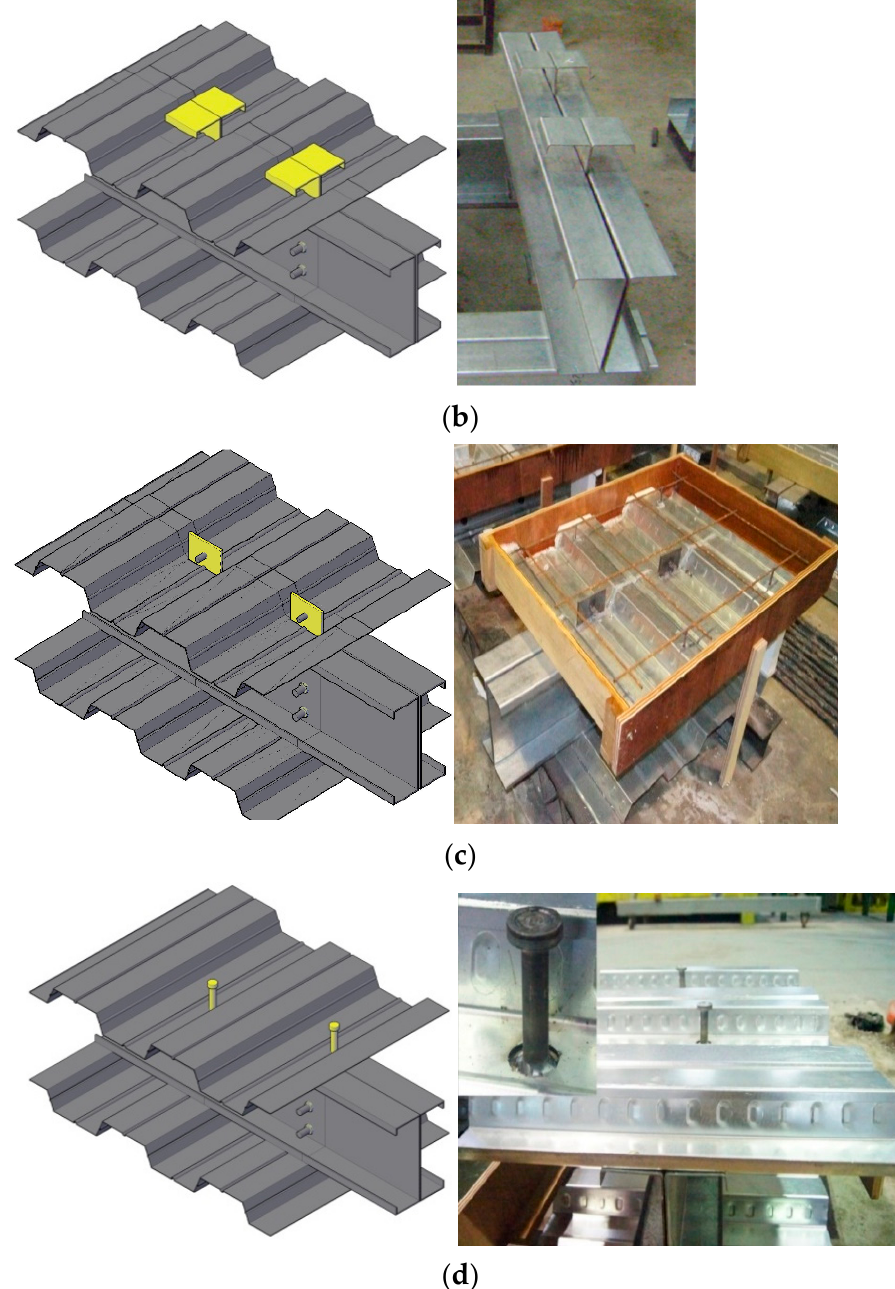
Figure 2. Shear connectors’ arrangement [21]. ( a ) SBSC shear connector. ( b ) DBSC shear connector. ( c ) HPSC shear connector. ( d ) HSSC shear connector.